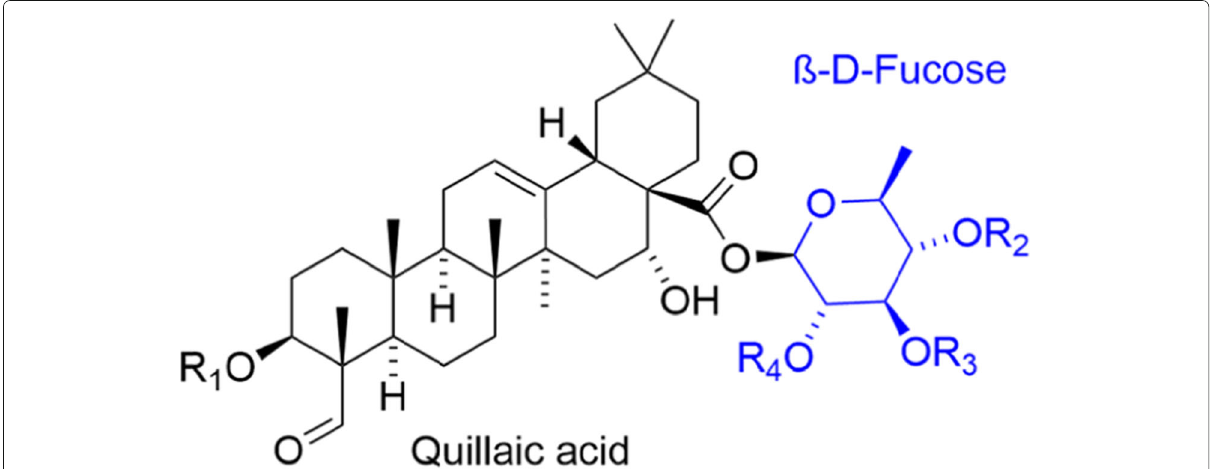
Fig. 1 General chemical structure of Quillaja saponin; R 1,2,3,4 represent saccharide or acyl residues. Adapted from Reichert et al. (2019)